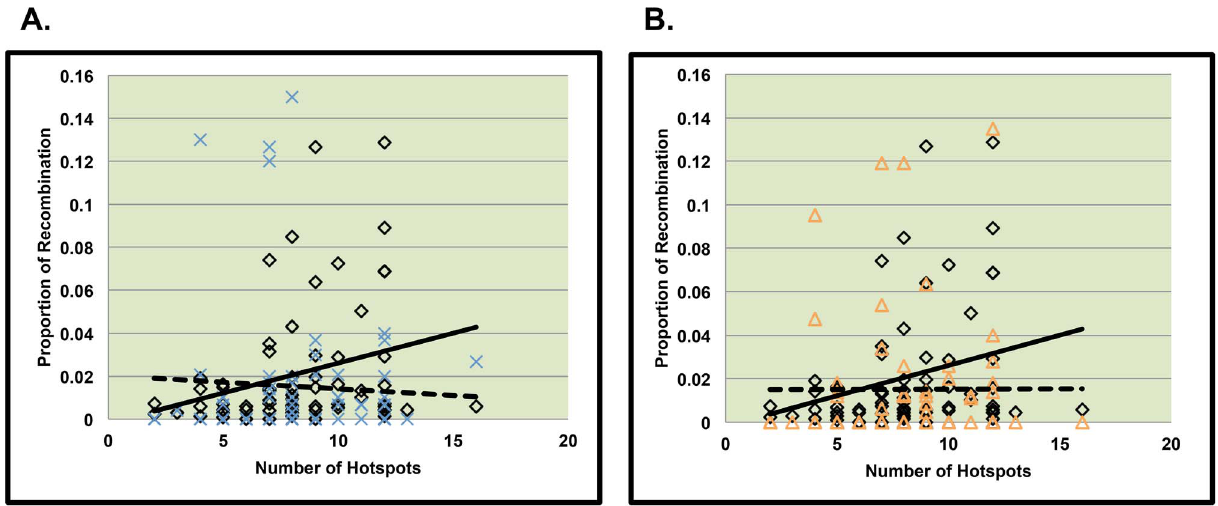
Figure 5. Comparison of slopes between MI or MII errors and controls for the proximal recombinant of double recombinant events. Figures 5A and 5B represent data from the proximal recombinant event of chromosomes displaying two recombinant events on 21q. The solid line represents the relationship between the number of hotspots per bin and the proportion of recombination per bin along normally segregating chromosomes 21. The dotted line represents the relationship between the number of hotspots per bin and the proportion of recombination per bin along chromosomes 21 from MI errors (figure 5A) and MII errors (figure 5B).